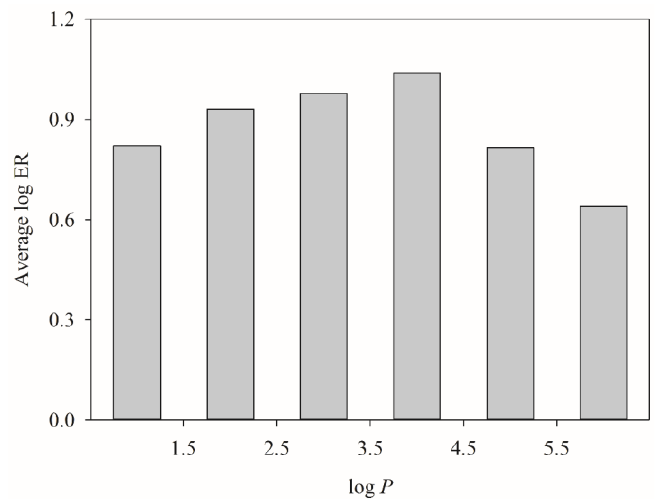
Figure 7. Average log ER vs. the distribution of log P .